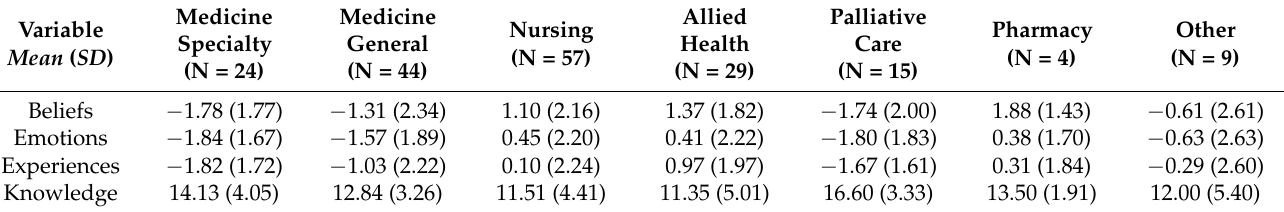
Table 3. Mean Scores per Discipline for Main Correlates.